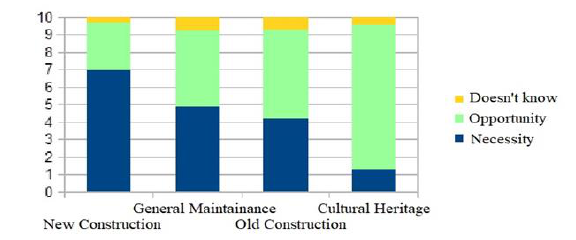
Figure 6 . Consideration of BIM in some application areas by public works operators (Figure by P. Fiamma).